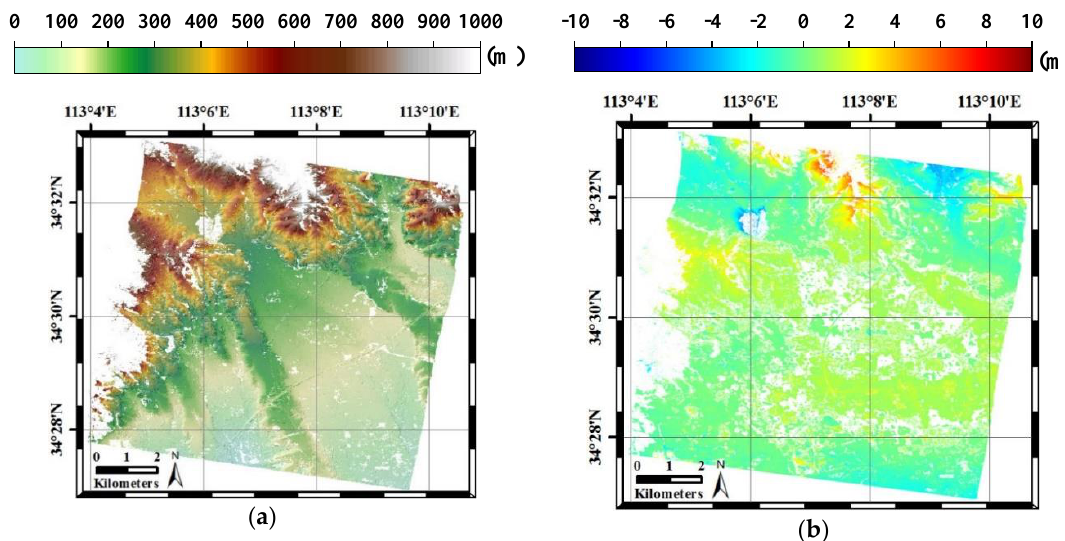
Figure 15. DEM acquired by Yaogan-29 sensor with GCPs ( a ) and the distribution map of the evaluation difference between the 1:2000-scale DEM and the obtained DEM ( b ).